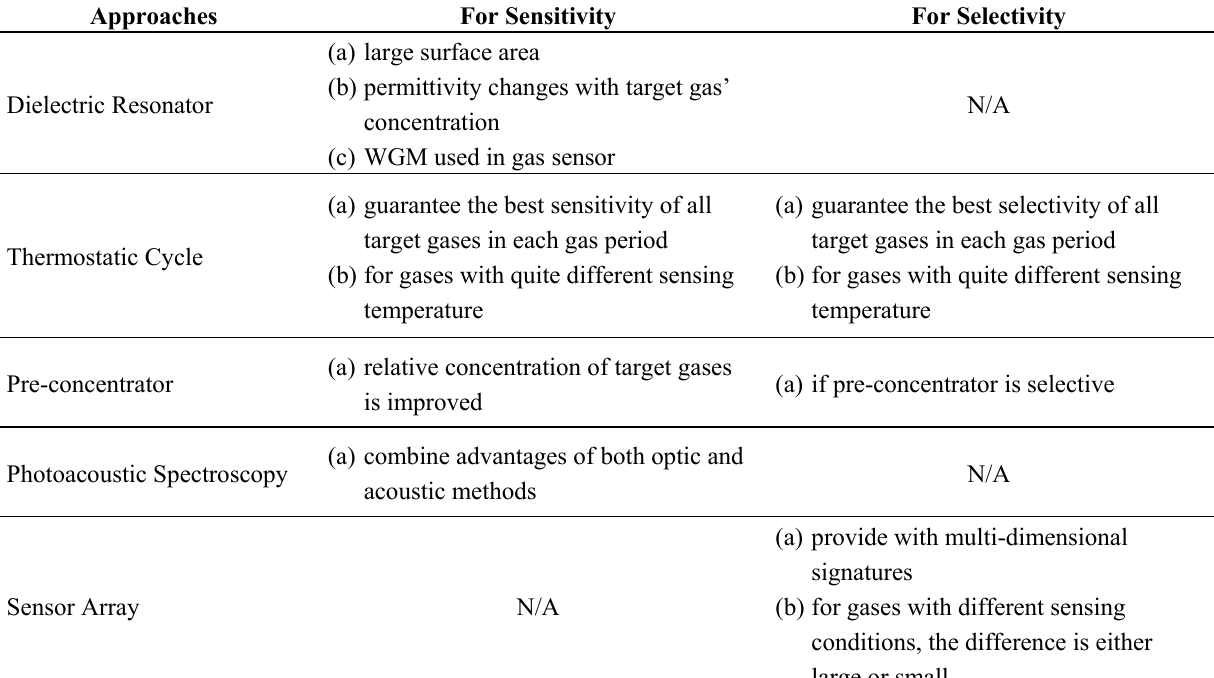
Table 2. Summary of approaches improving sensitivity and